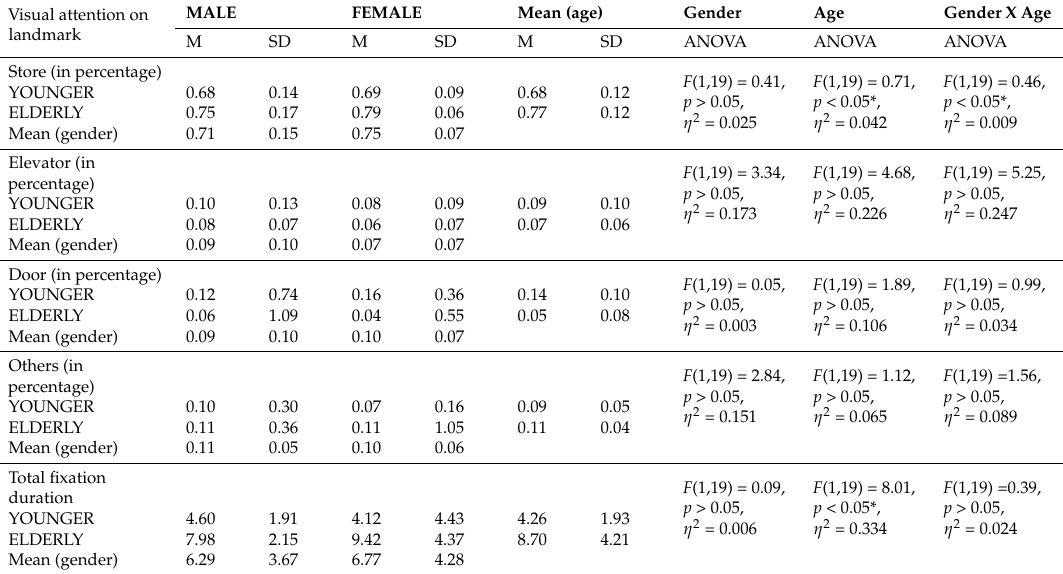
Table 4. Descriptive and inferential statistics for visual attention on the landmark.